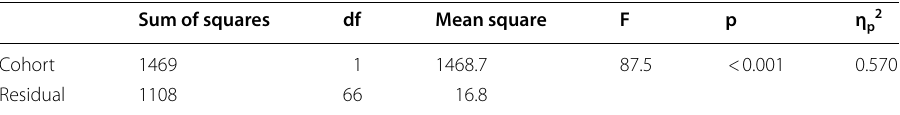
Type 3 sums of squares